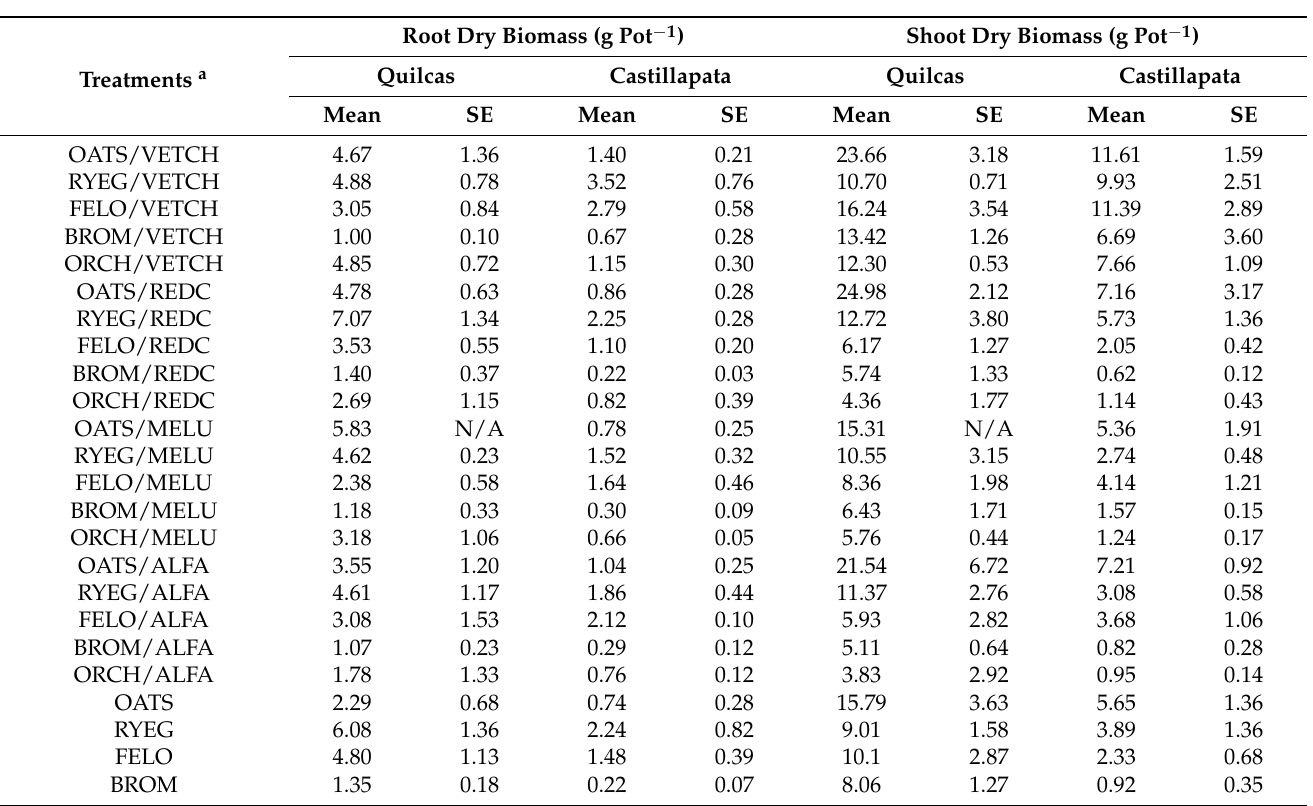
Table 4. Production of total roots and shoot biomass by treatment and soil type. The ANOVA results for each main factor and their respective interaction are presented at the bottom with significant values in bold ( p < 0.05). Means and standard error (SE) correspond to the original data (without transformation), while p -values are based on the transformed